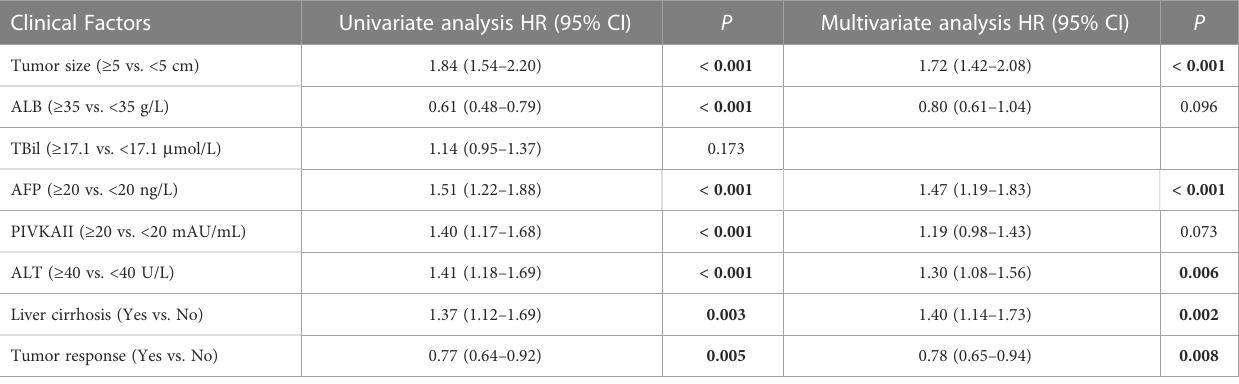
TABLE 4 Univariate and multivariate Cox regression analysis to identify independent prognostic factors of PFS in advanced ICC patients treated with Camrelizumab and